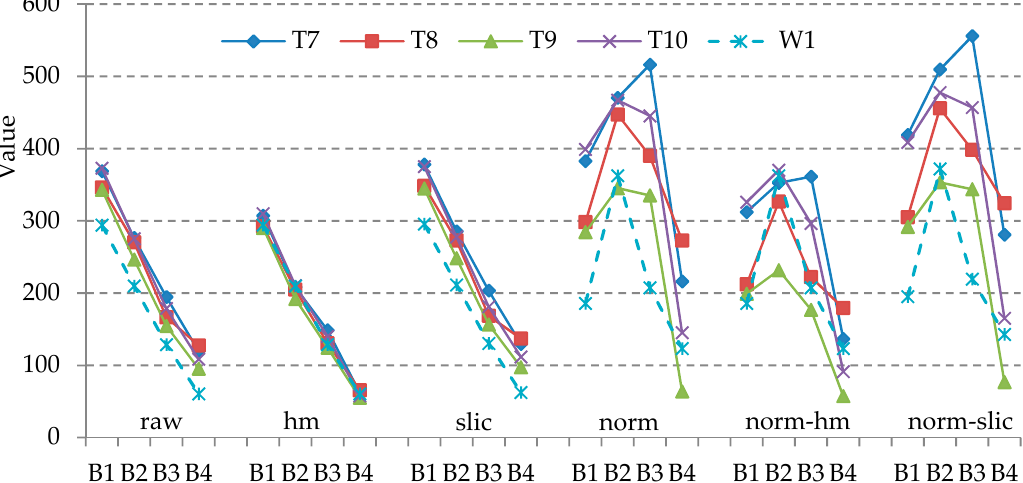
Figure 9. Each group of spectra refers to the mean spectrum of water samples from W1 and T7-T10 (D609). From left to right, they are from L1A data, hm enhanced image, slic enhanced image, norm enhanced image, norm-hm enhanced image, and norm-slic enhanced image. Refer to Table 3A for a detailed explanation of those terms. Values on the y-axis refer to the digital number for the first three groups and reflectance with a scale factor of 10000 for the last three groups.